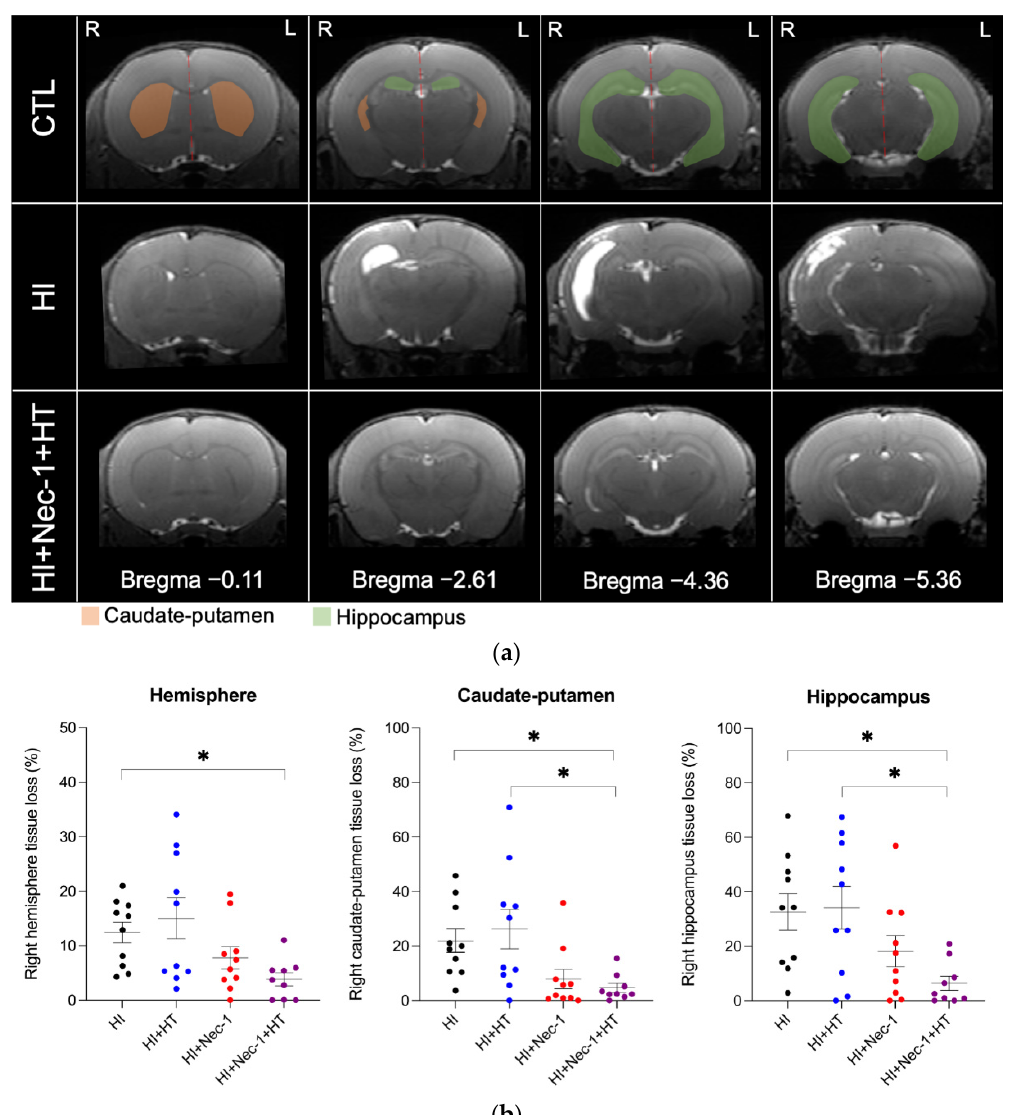
Figure 4. MRI brain volumes of HI ± Nec-1 ± HT-exposed rats at P20-21. ( a ) Representative MRI images in CTL versus HI versus HI+Nec-1+HT conditions. ( b ) Ratio in percentages of tissue loss in the hemisphere, caudate-putamen, and hippocampus in HI ± Nec-1 ± HT-exposed rats. The number (n) of rats used was n = 9–10 per conditions from 5 litters. The bars indicate the mean ±